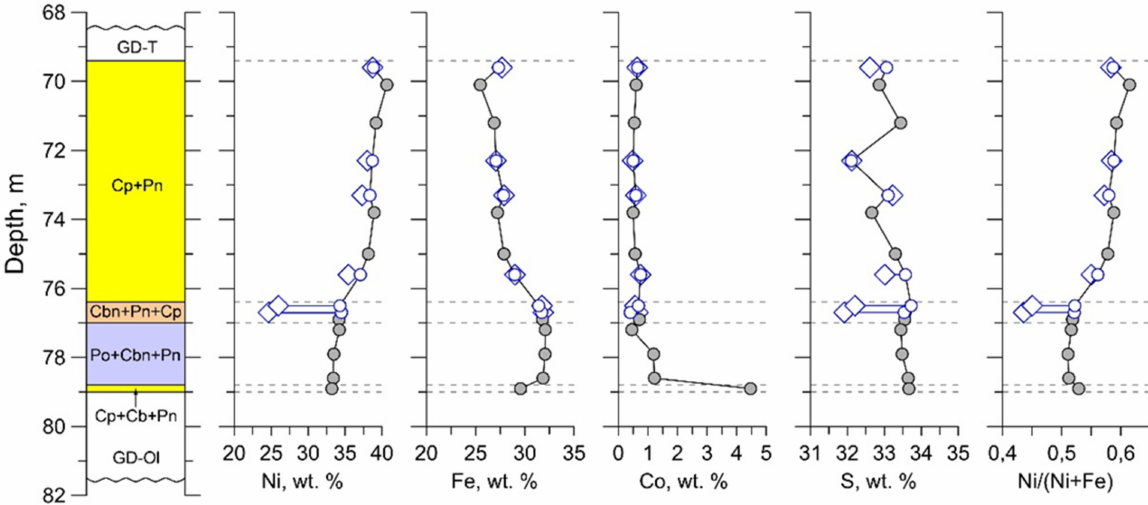
Figure 5. Variations in the average composition of pentlandite in the ore body cross-section, EM-7 core sample (Table 1). Circles show average compositions of ore-forming pentlandite. Squares show the compositions of pentlandite with the highest palladium content. Empty figures connected by lines show the compositions of Pd-rich and ore-forming pentlandite in the same sample. Abbreviations: Cbn—cubanite; Cp—chalcopyrite; Pn—pentlandite; Po—pyrrhotite; GD-OL—olivine gabbro-dolerite; GD-T—taxitic